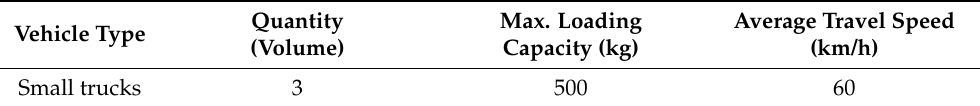
Table 6. Vehicle parameters.